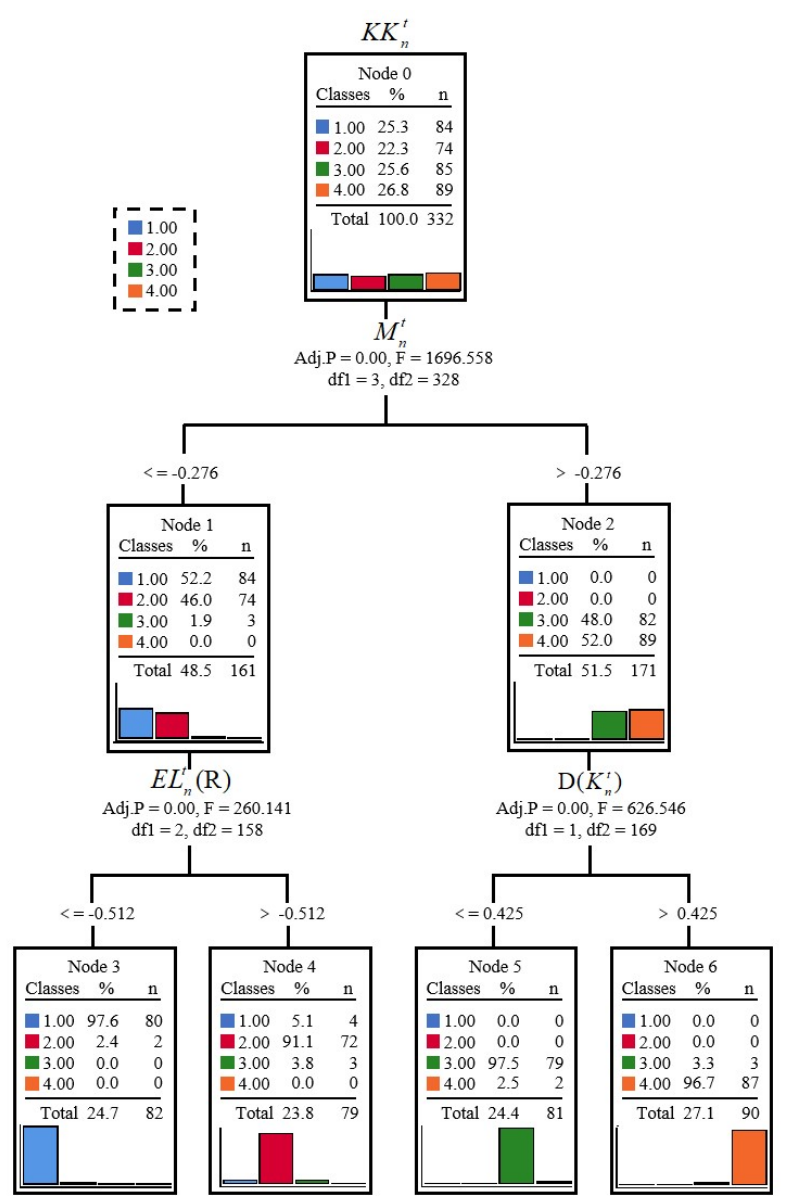
Table 11. Prediction accuracy values of QUEST-based lower limb motion comfort level analysis and determination model.